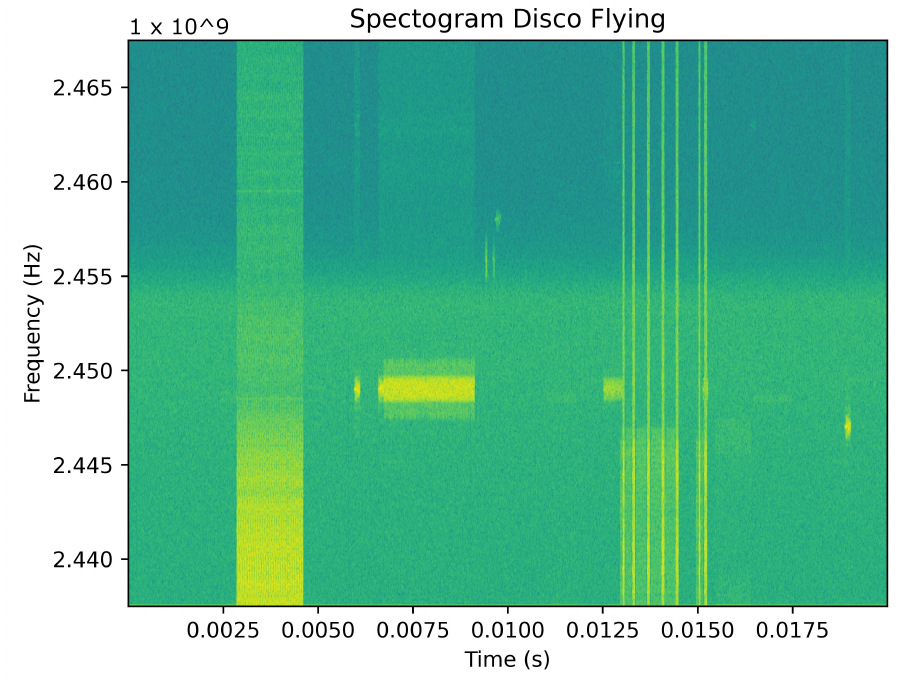
Figure 12. Spectrogram: Disco